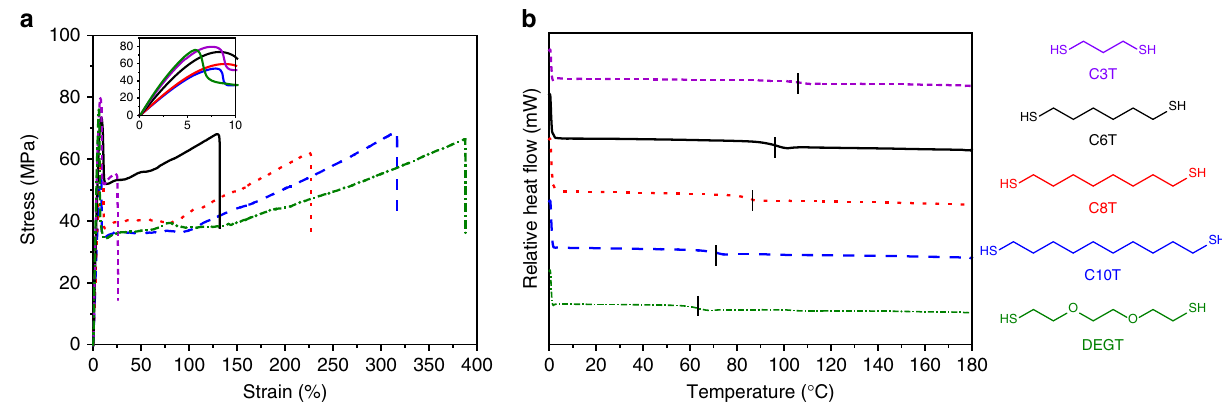
Fig. 5 Effect of thiol comonomer on thermomechanical behaviour. a Exemplary stress vs strain curves tested at 10 mm min − 1 , 22 °C. b DSC thermograms of 2nd heating cycle tested at 10 °C min − 1 . Position of T g for each polymer sample is indicated with a vertical hash